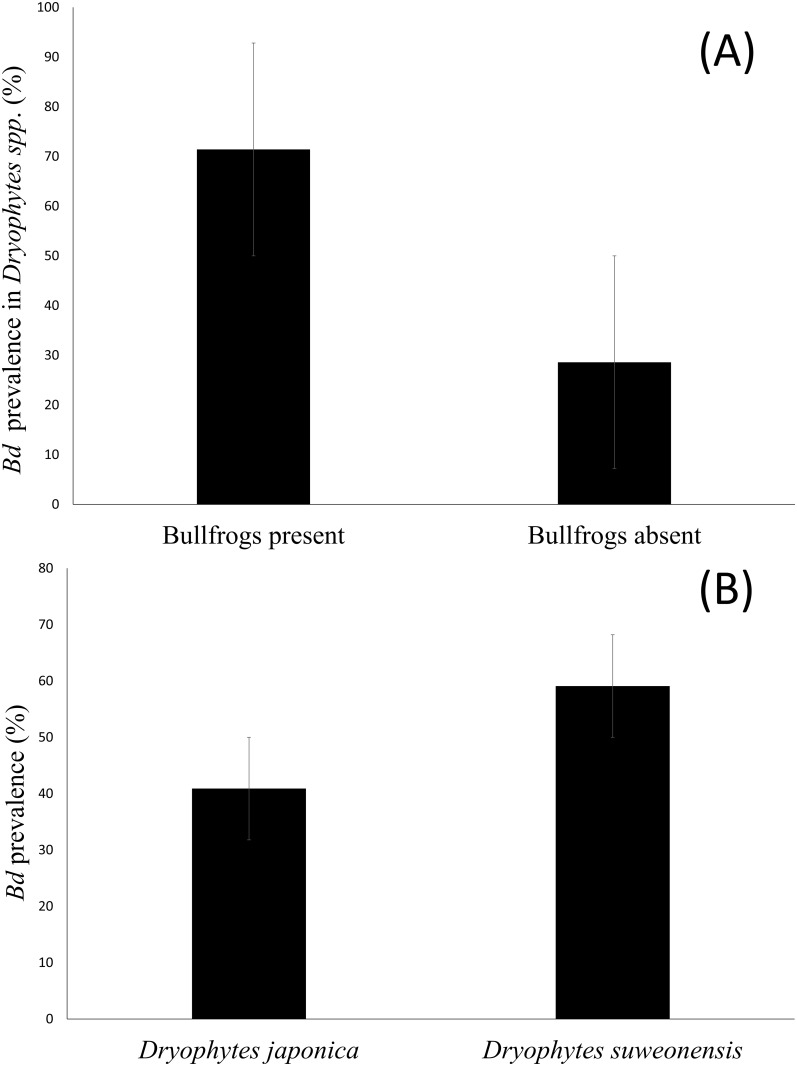
(A) Percentage of Korean treefrogs infected by Bd as a function of bullfrog presence. The graph is representative of the whole treefrog population for both species at sites with bullfrogs and at sites without bullfrogs. (B) Bd prevalence for each treefrog species in percent. The Bd prevalence was lower in Dryophytes japonicus by a factor of 0.7. For both figures, the vertical thin bars at the center of the percentage thick bars are standard error bars.